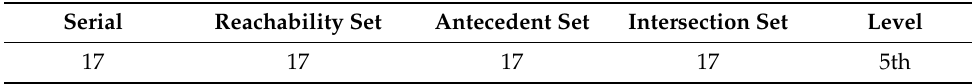
Table A5. Level partitioning (Level